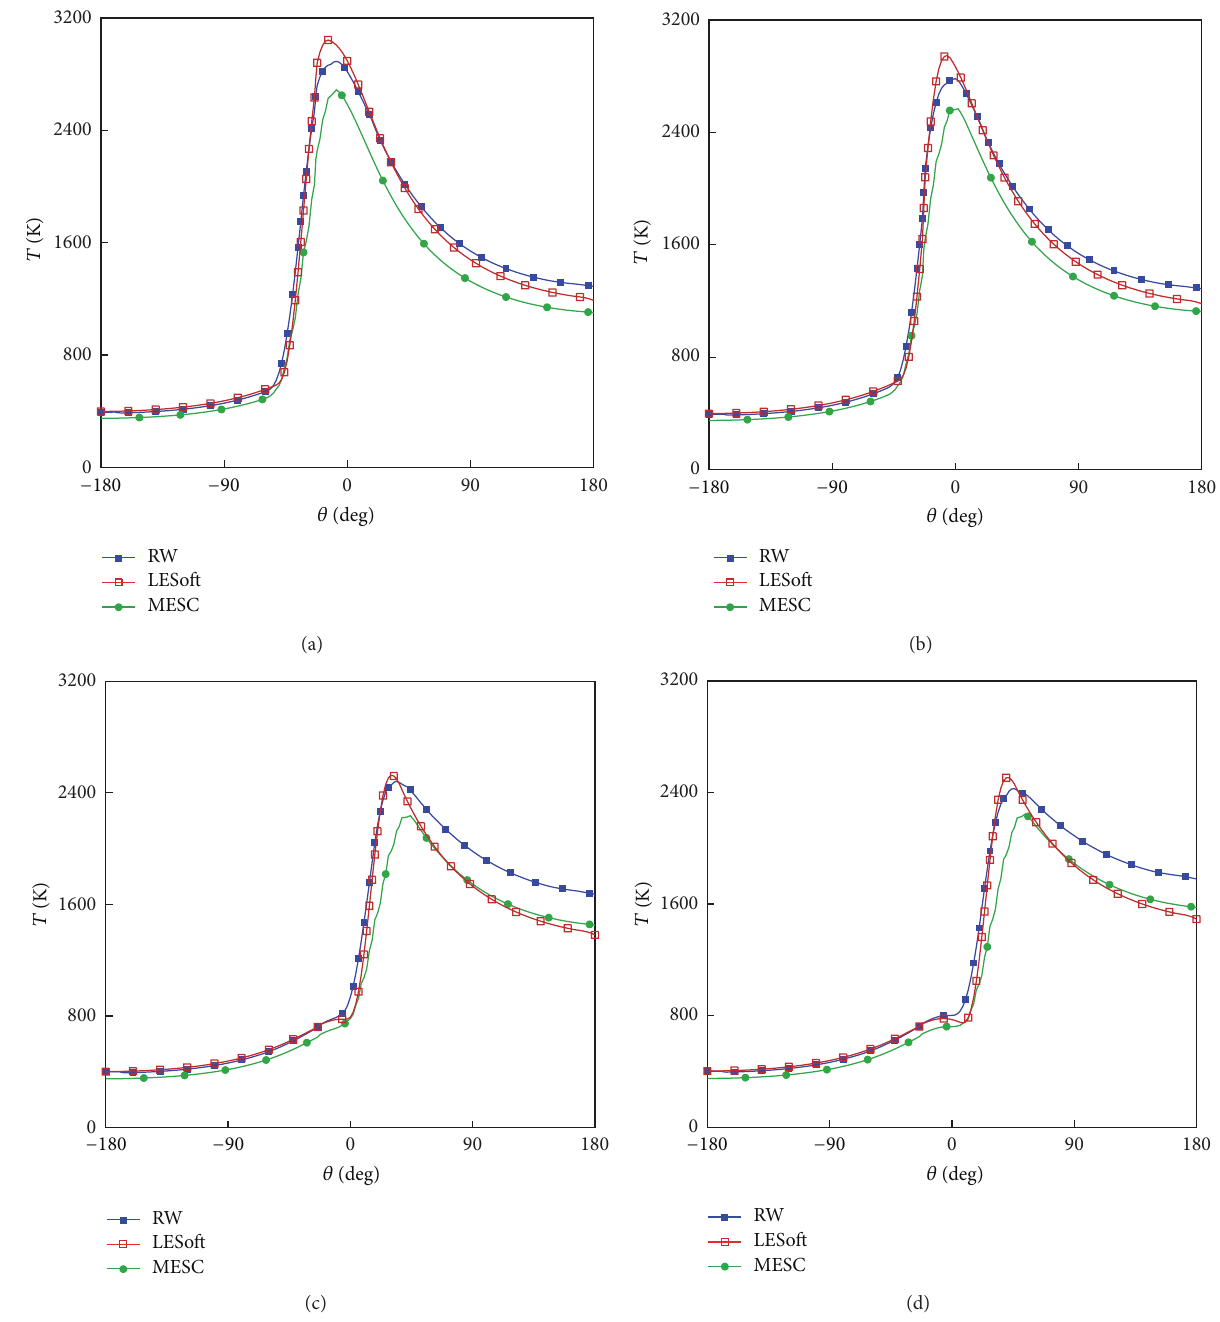
Figure 12: Profiles of temperature for different ignition timing of − 60 (a), − 50 (b), − 10 (c), and 0 (d) degrees.